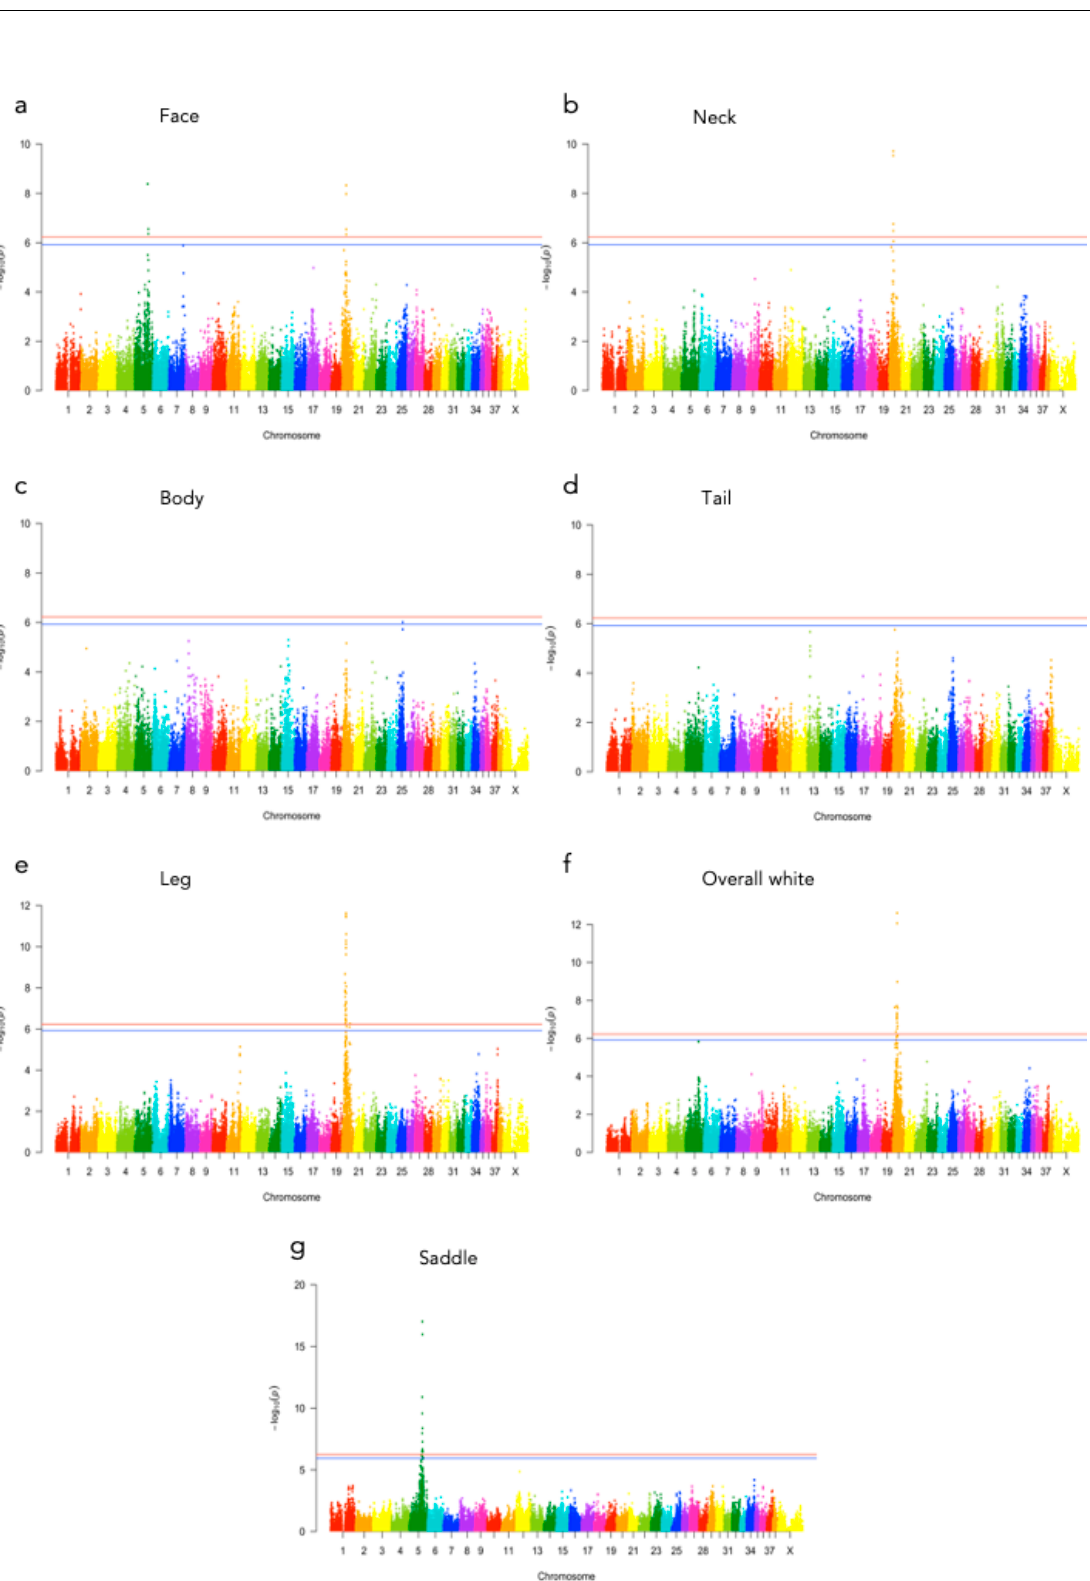
Figure 3. Manhattan plots of GEMMA p-values for each fur coloration phenotype ( a ) face, ( b ) neck, ( c ) body, ( d ) tail, ( e ) leg, ( f ) overall white and ( g ) saddle. Genome-wide significance levels are displayed as a red line (Bonferroni 5%) and a blue line (Bonferroni 10%).